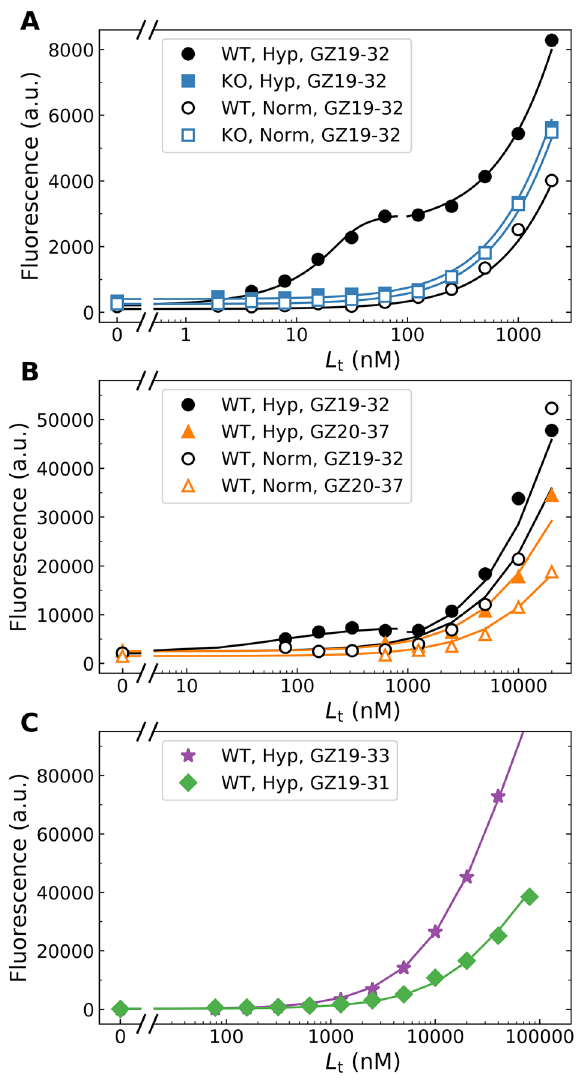
Figure 9. Dosing profiles of the fluorescein-labeled GZ compounds showing the specific binding of GZ19-32 to CAIX expressed only on hypoxia-grown WT HeLa cells (occurring at 100 nM after 5 min incubation ( A ) and at 500 nM after 2 min incubation ( B ) and the non-specific binding to unknown targets other than CAIX by all other compounds to both the WT and CAIX-KO HeLa cells grown both under hypoxia and normoxia conditions. ( C ) Non-specific binding of sulfonamide (GZ19-31) and non-sulfonamide methylated (GZ19-33) compound after 20 min